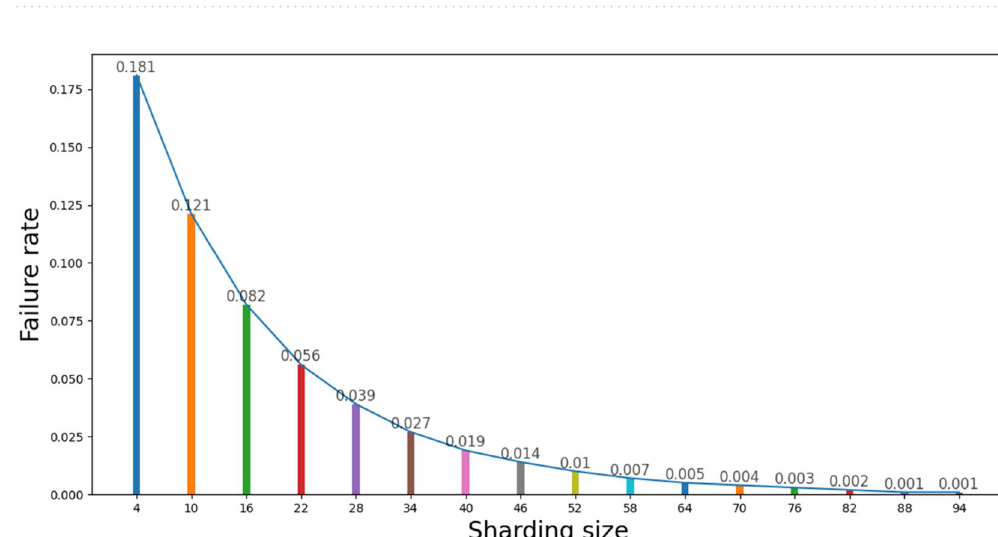
Figure 7. Intrashard consensus failure rate for different shard